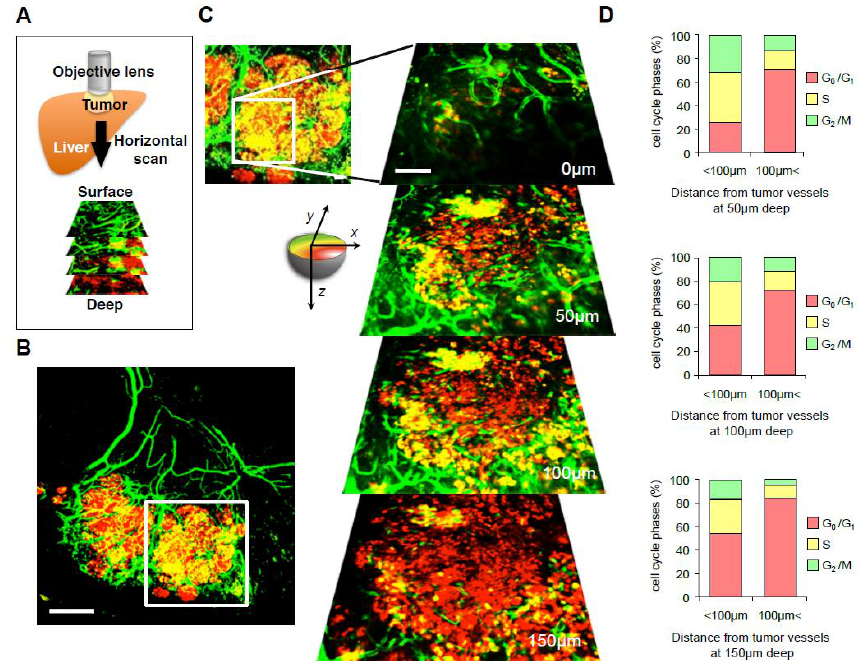
Figure 4. Imaging nascent tumor vessels and cancer cell-cycle phase. ( A ) The schematic diagram shows the method of repeated intravital CLSM imaging of FUCCI-expressing cells growing in nestin-driven green fluorescent protein (ND-GFP)-expressing transgenic nude mice in which tumor nascent vessels express GFP. ( B ) Representative whole image of orthotopic FUCCI-expressing tumor in ND-GFP-expressing nude mice. ( C ) Representative images of FUCCI-expressing cancer cells at various depths in a tumor in the liver at 28 days after implantation are shown. ( D ) Histogram shows the cell cycle phase distribution at different distances (xy-plane) from blood vessels. Scale bars represent 100 μm. (Reproduced from [46] with the permission of Taylor and Francis).